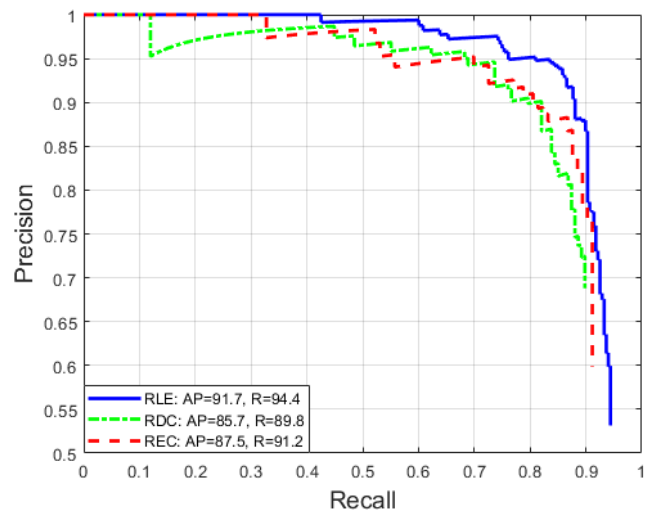
Figure 10. ACF algorithm evaluation.